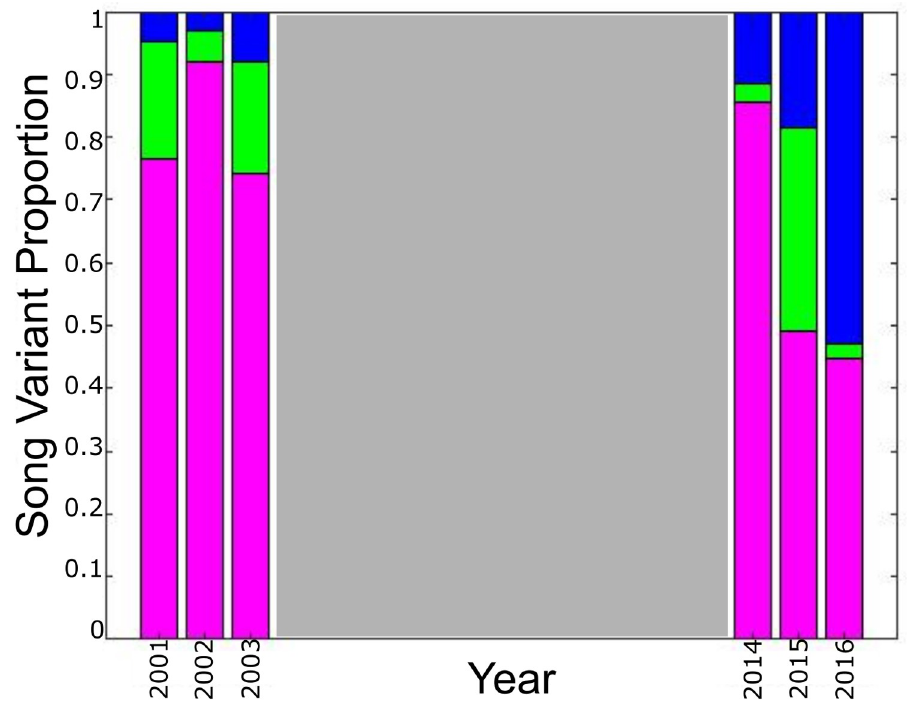
Fig 6. Annual song variant proportions. Proportion of pulses per annual recording effort belonging to each call variant. Singlets are in pink, doublets in green, and triplets in